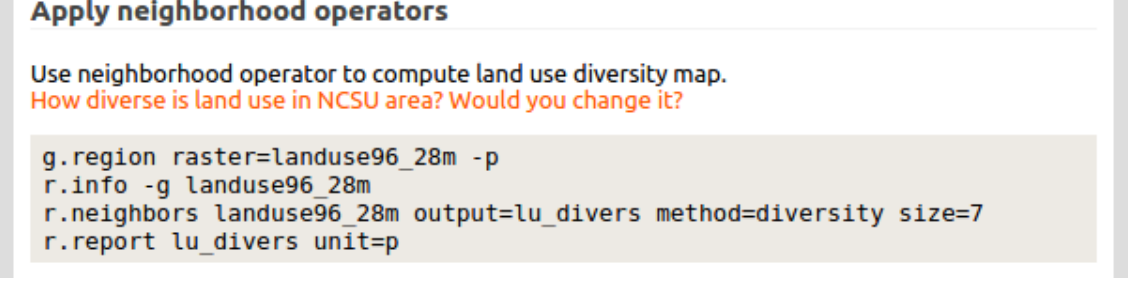
Figure 1. Instructions for GRASS GIS part of the assignment typically consist of general description and modules with parameters to be used in the form of